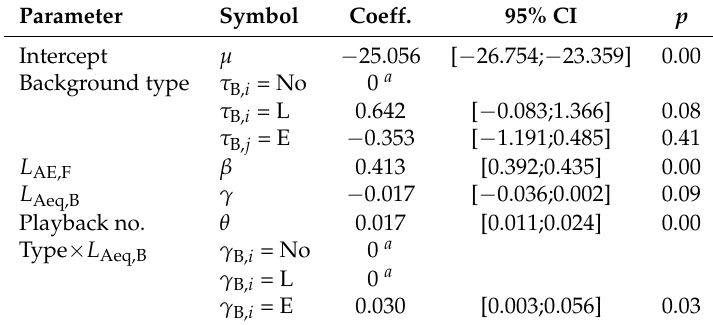
Table 3. Experiment 1, model 2: model coefficients (Coeff.), their 95% CI, and probabilities ( p ) of the linear mixed effects model for annoyance. The parameters and symbols are explained in Equation (2).